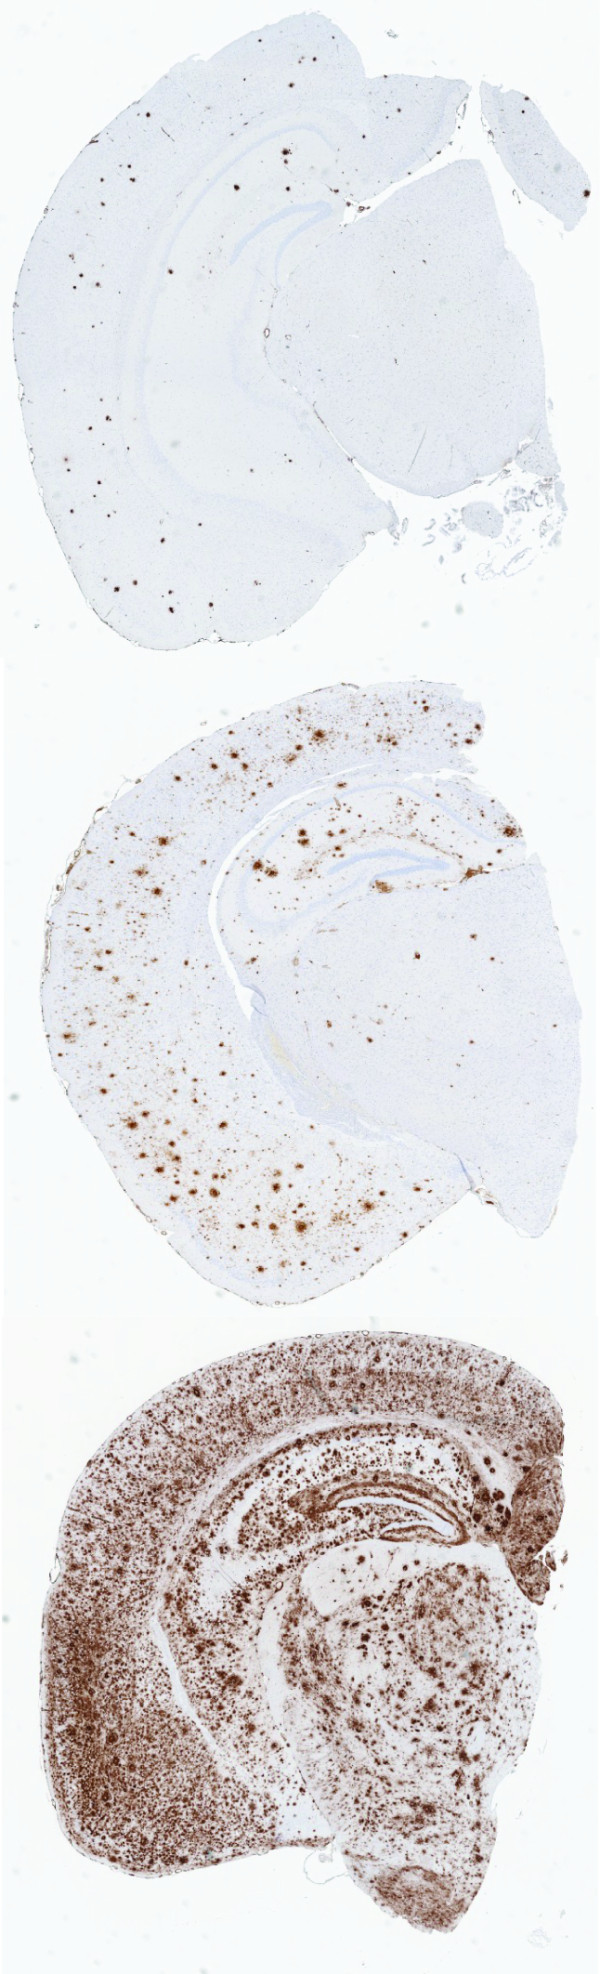
Representative images of Aβ deposits, stained with pan Aβ 1-16 (33.1.1) antibody, in the brain sections of (A) three-, (B) six-, and (C) 12-month-old CRND8 mice. The total amyloid burden in the combined areas of cortex, hippocampus and amygdala was 11.0%, 52.9%, and 83.1%, respectively for the sections presented in A, B, C panels.